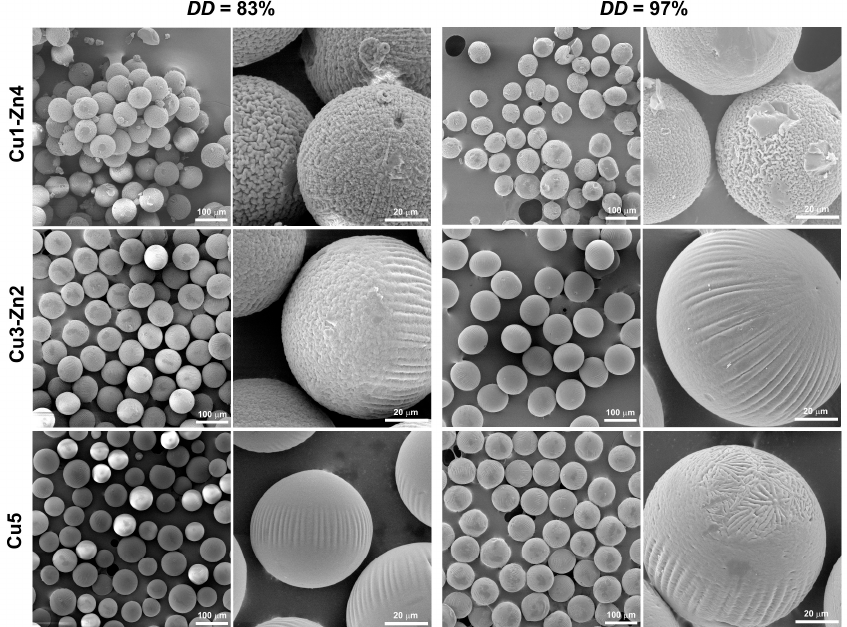
Figure 4. SEM micrographs of dry bimetallic chitosan microgels prepared from chitosan with different deacetylation degrees. The scale bars are 100 and 20 µm.